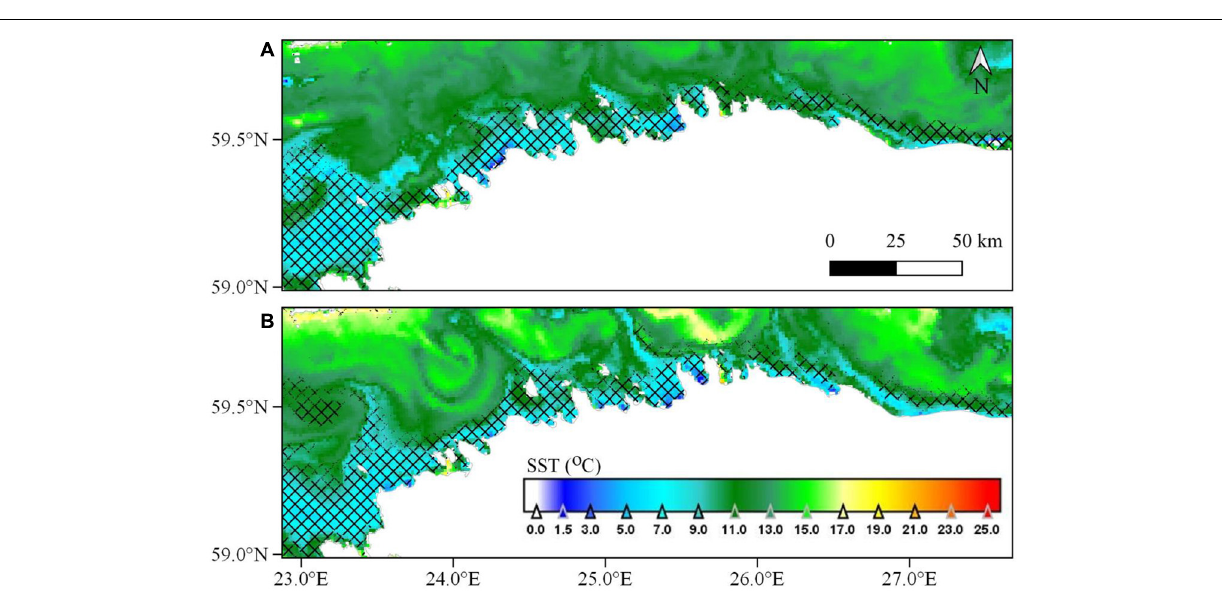
FIGURE 7 | Sea surface Temperature (SST) maps derived from SLSTR data on (A) 14 June 2020 and (B) 21 June 2020 (Gulf of Finland). The area hatched in black indicates the condition R ( 490 )/ R ( 560 ) ≥ 0 . 77 fulfilled from the OLCI data from the same overpass date with the SLSTR SST